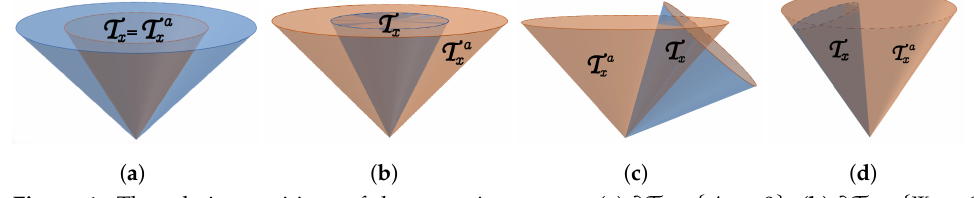
Figure 1. The relative positions of the spacetime cones. ( a ) ∂ T x : { A = 0 } , ( b ) ∂ T x : { Ψ = 0 }